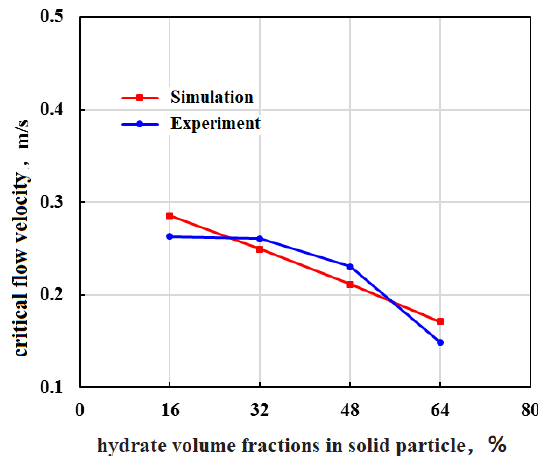
Figure 14. The experimental and theoretical curves of the critical velocity of particles under different solid particle sizes.